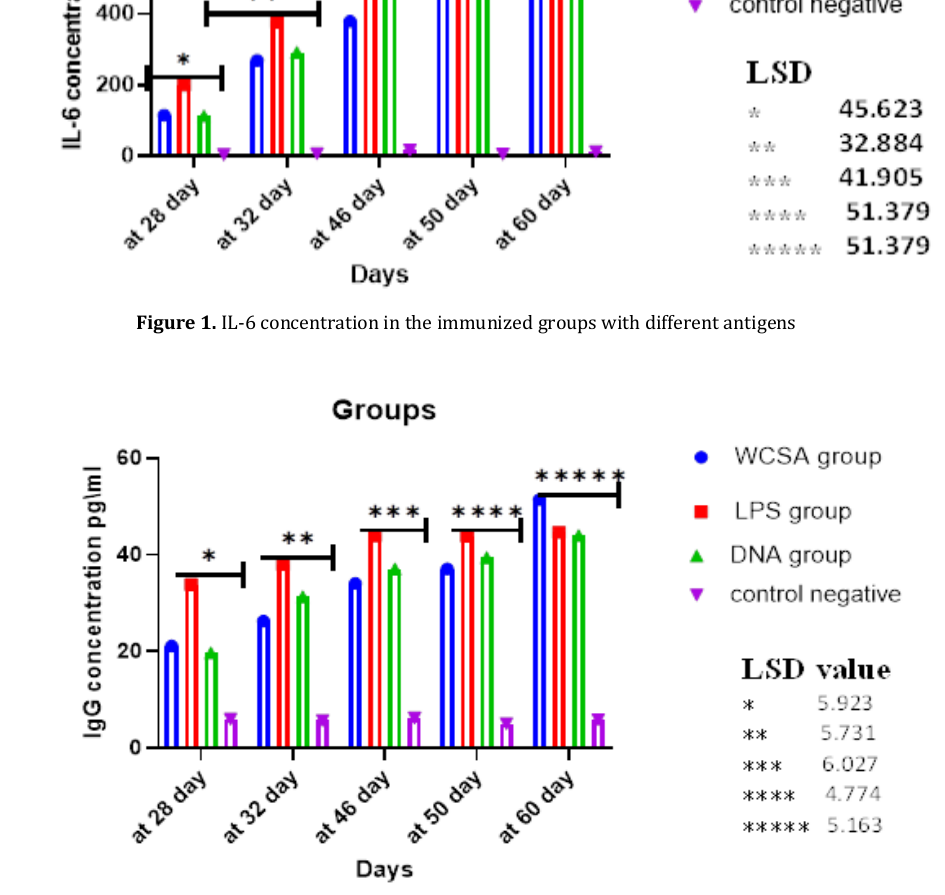
Figure 2. IgG concentration in the immunized groups with different antigens